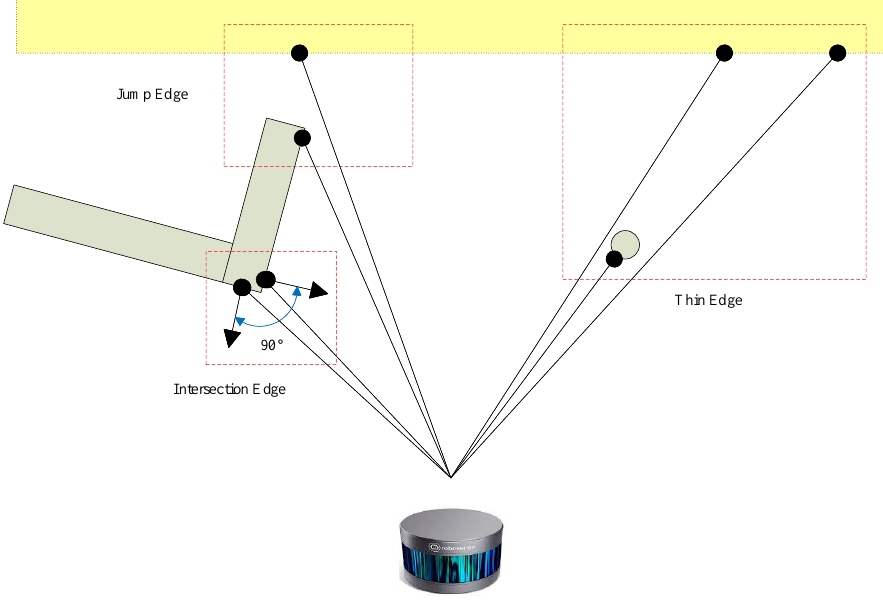
Figure 3. Our edge feature selection scheme. An intersection edge is a planar point with a smaller depth than its neighboring points and a larger angle, e.g., 90 ◦ , between the corresponding normal vectors. A jump edge is a plane point with a much smaller depth than its neighboring points. A thin edge is a point with two neighbors in the same row or column that have much larger depths. The depth is infinite if the yellow plane with the dashed boundary does not